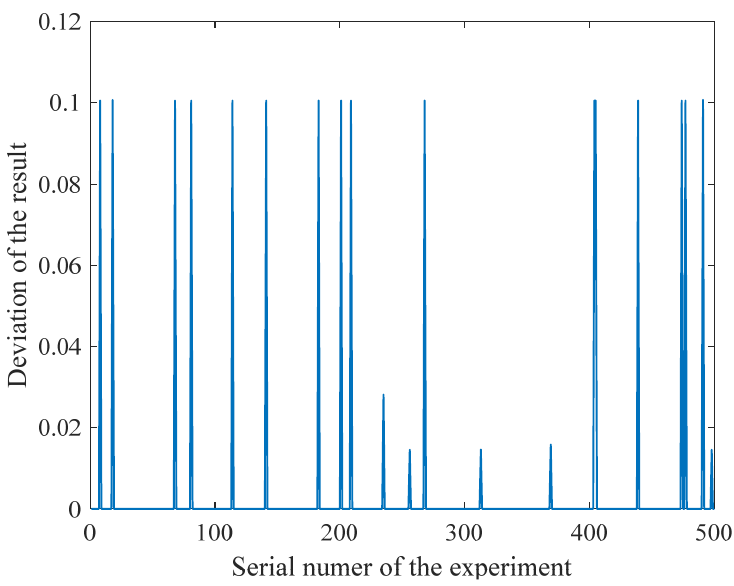
Figure 8. Deviations of the optimal image contrasts obtained by 500 random experiments.